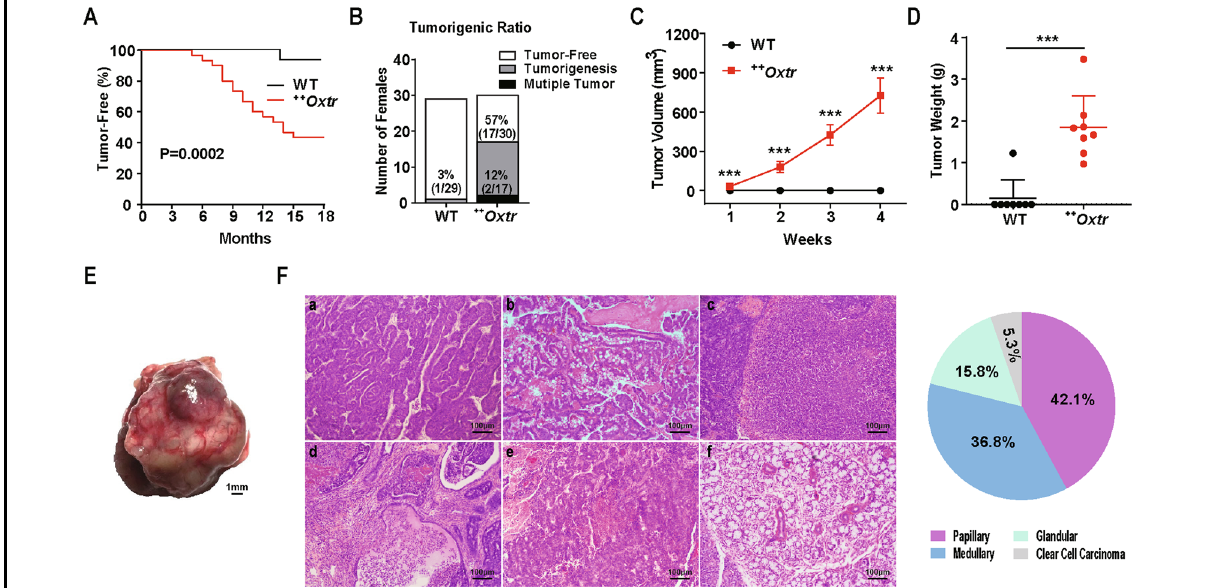
Fig. 1 Tumor onset and histology analysis. A Kaplan – Meier plot of tumor-free survival for wild-type (WT) ( n = 29) and ++ Oxtr females ( n = 30). B Tumor incidence analysis, WT, n = 29 and ++ Oxtr , n = 30. C Tumor growth measurement by volume ( n = 9). D Tumor weights 30 days after palpation ( n = 8). Data were represented as mean ± SD. *** P < 0.001, calculated using two-tailed unpaired t -test and Log-rank (Mantel – Cox)